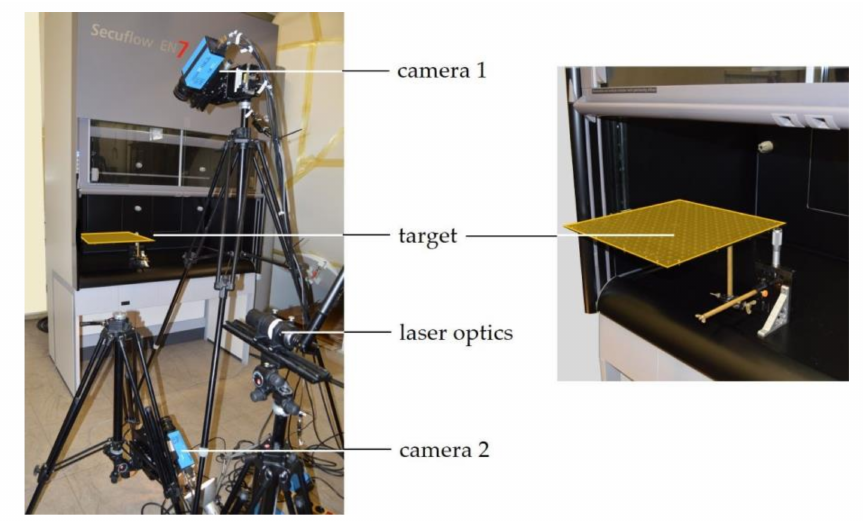
Figure 17. PIV measurements on the laboratory fume hood—photograph of the experimental